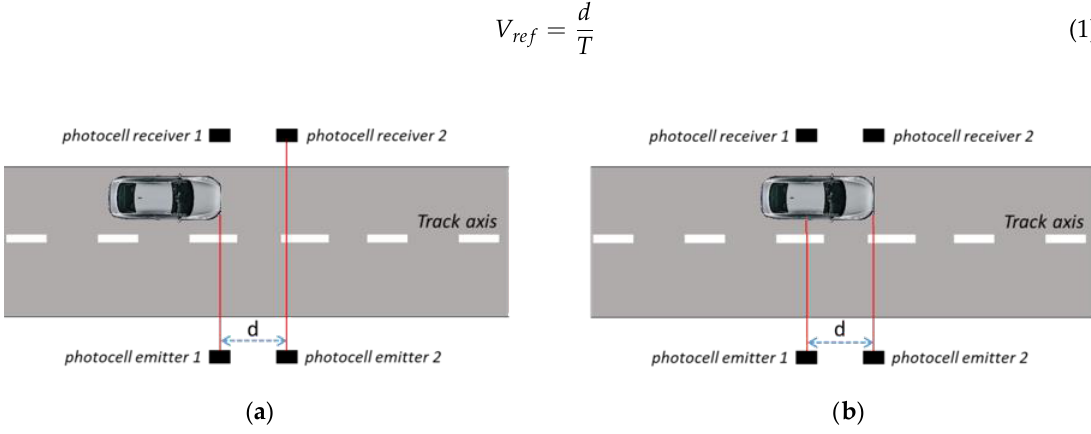
Figure 2. Representation of the vehicle that is seen by the first ( a ) and second ( b ) photocells couple.